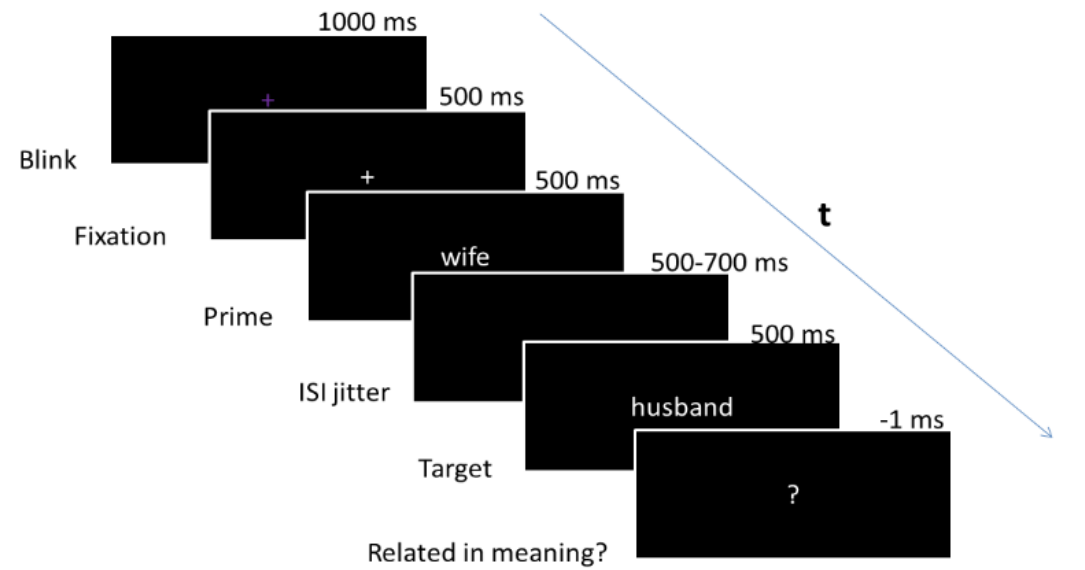
Figure 2. Sample trial across time (t) from the semantic judgment task while event-related potentials (ERPs) were recorded.